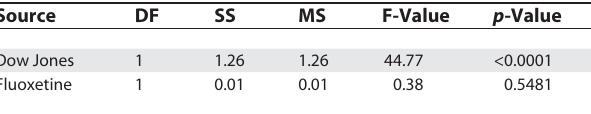
Table 3. Type III Analysis of Variance Table for Regression